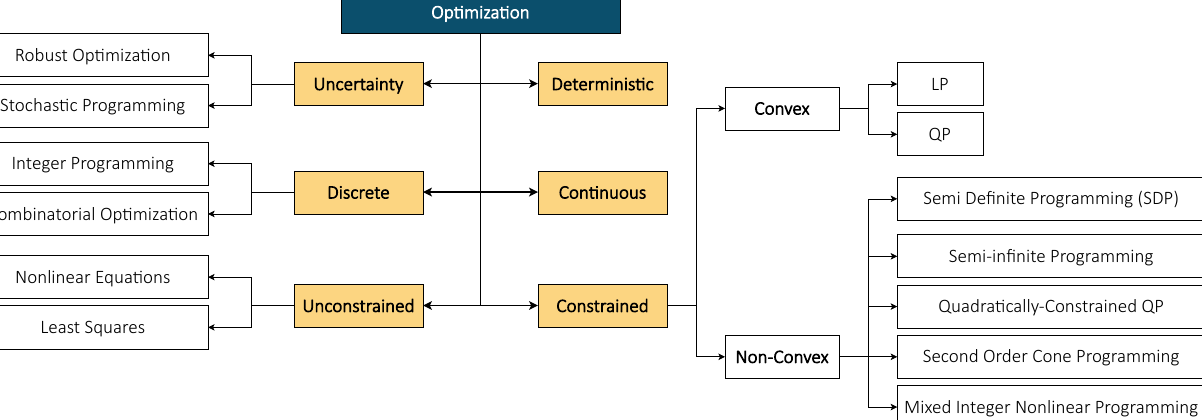
Figure 11. Optimization taxonomy in